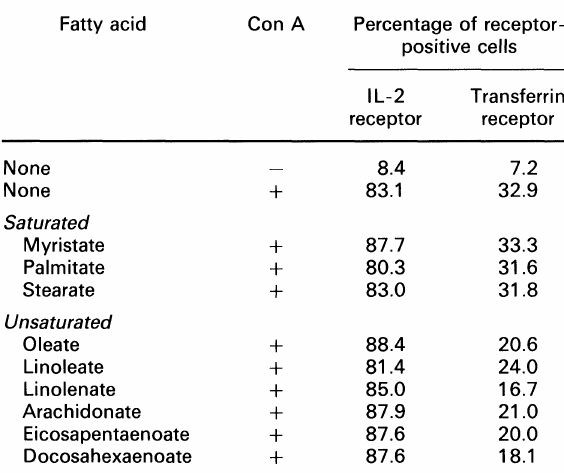
Table 3. Effect of fatty acids on the expression of receptors for IL-2 and transferrin by Con A-stimulated rat lymphocytes Fatty acid Con A